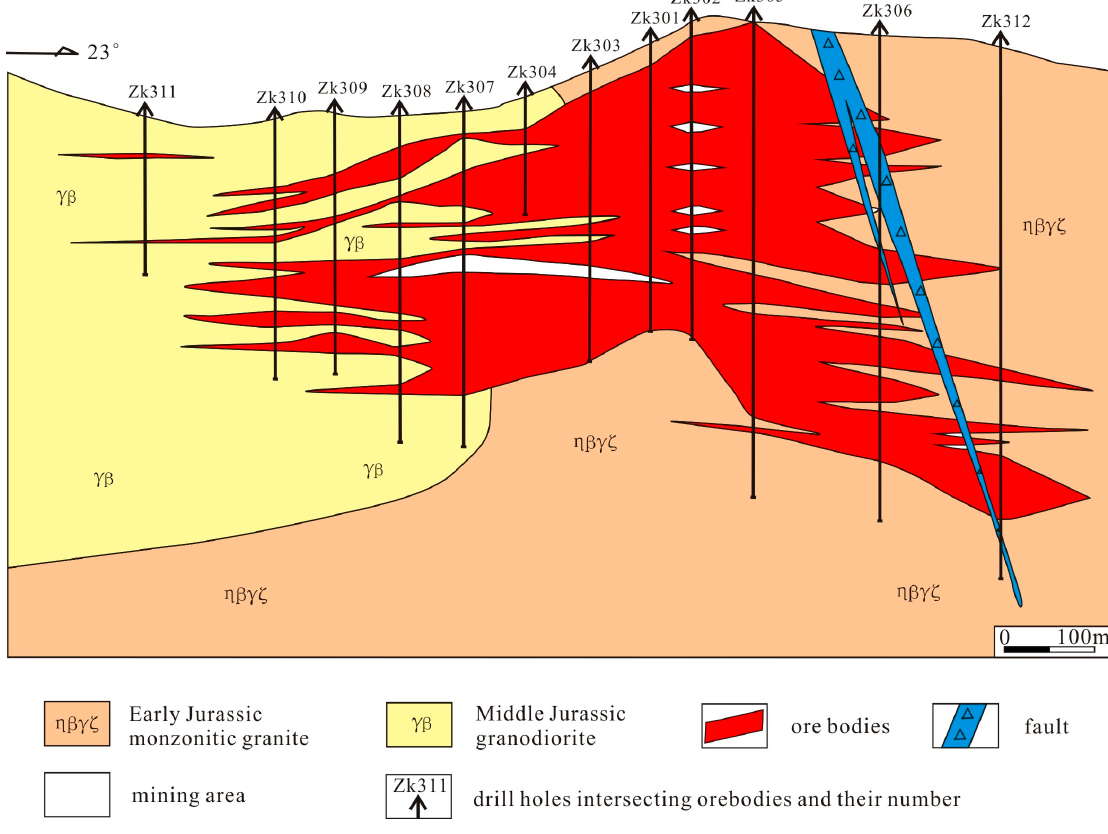
Figure 4. Geological cross-section of Line No. 3 through the Jidetun Mo ore deposit (modified after [9,10]).